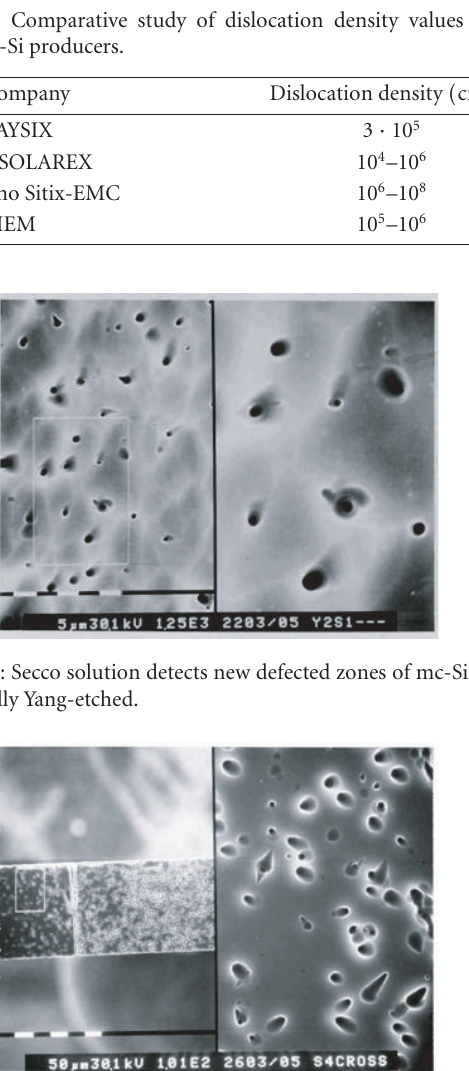
Figure 6: Various pit shapes due to the overlapping of several dis- location